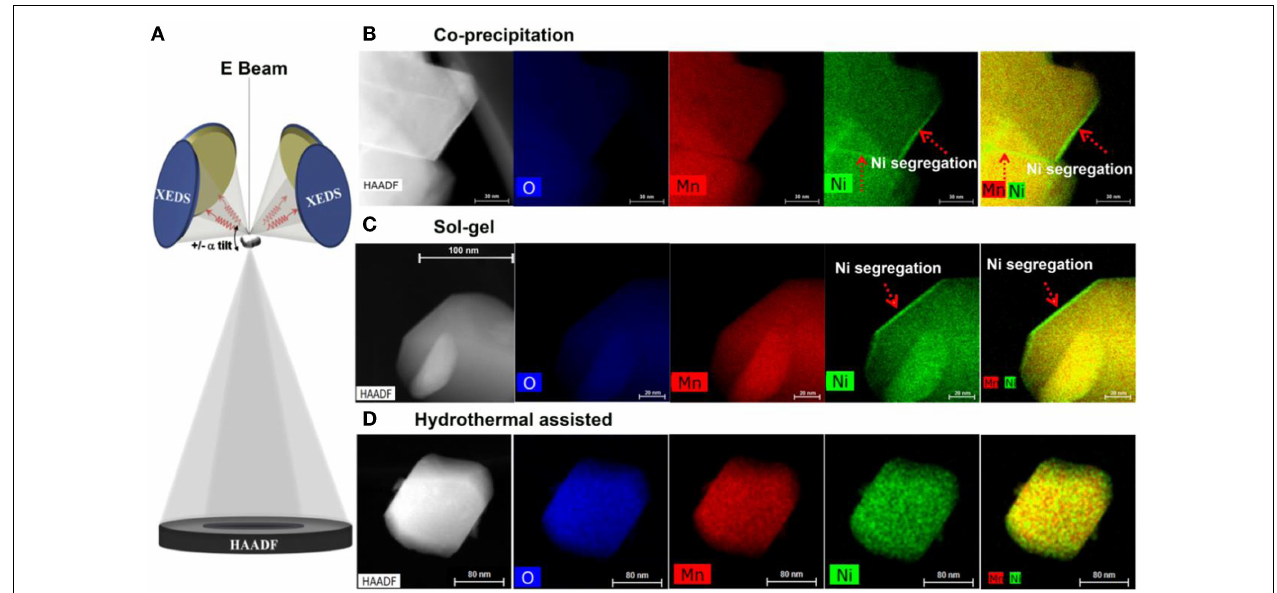
(B) CP material; (C) SG material; and (D) HA material. CP and SG materials show clear Ni-rich surface layer as indicated by the red arrows. HA sample shows no Ni-rich surface layer (Zheng et al., 2014a). Reprinted with permission from Zheng et al. (2014a). Copyright 2014 American Chemical